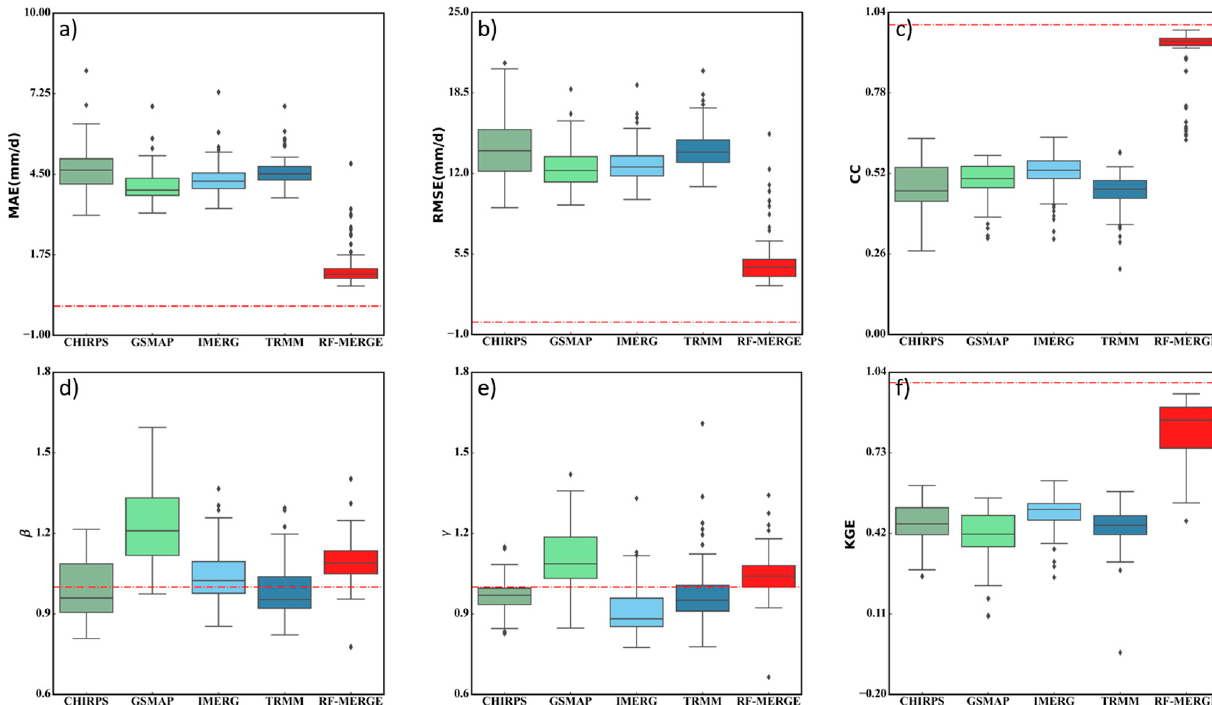
Figure 4. Boxplots of ( a ) MAE, ( b ) RMSE, ( c ) CC, ( d ) β , ( e ) γ , and ( f ) KGE at daily scale from 2003 to 2017. The optimal value is indicated by the red dashed line.